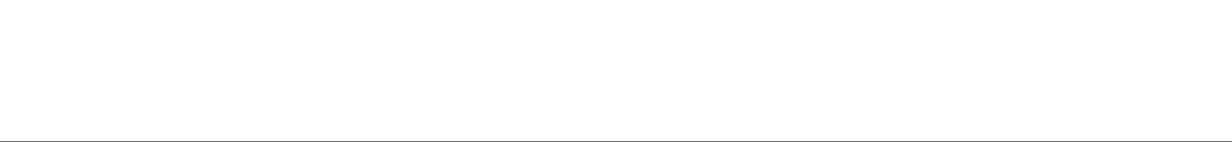
Frontiers in Chemistry |